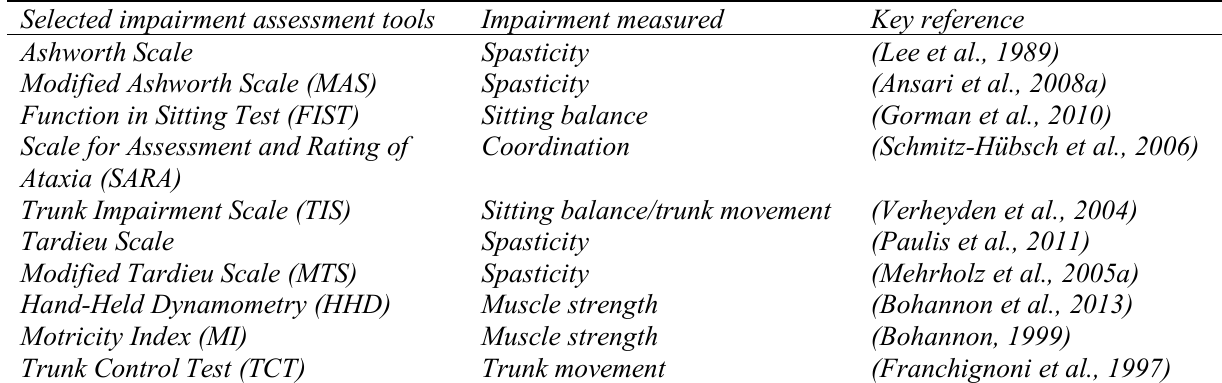
Table 1. List of included impairment assessment tools, the impairment they measure, and the key scientific reference for each